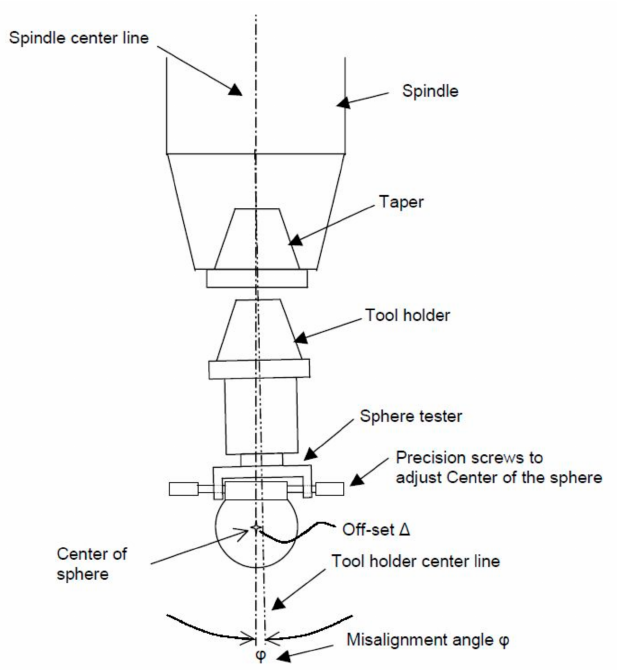
Figure 18. Spindle, holder, and ball standard